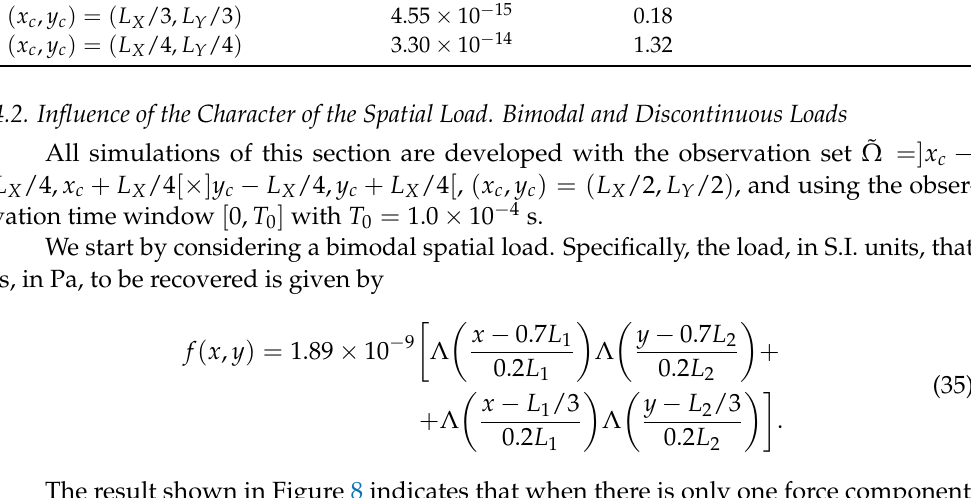
Table 3. Absolute and relative errors. Influence of the position of the observation set. Position of the Center Error ( f 1 )( Pa ) Error R ( f 1